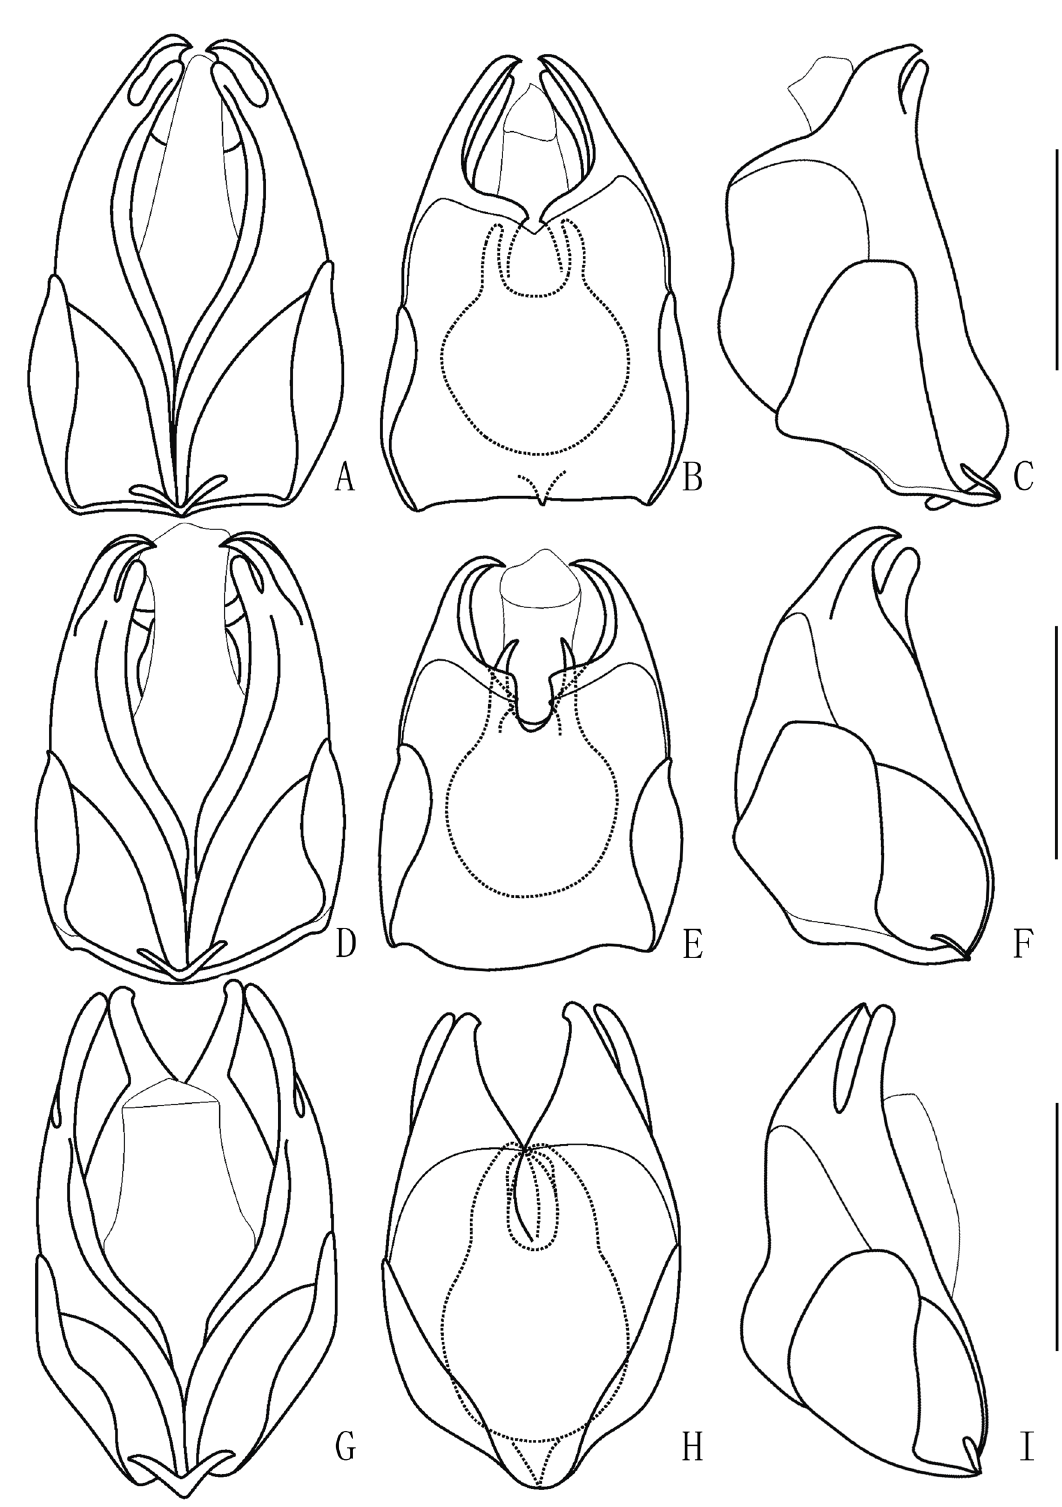
Fig. 10. Aedeagus (A, D, G = ventral view; B, E, H = dorsal view; C, F, I = lateral view). A‒C . Stenothemus chongqingensis Y. Yang & H. Liu sp. nov., holotype (MHBU HBU(E) 410028). D‒F . S. flavicollis Y. Yang & S. Ge sp. nov., holotype (MHBU HBU(E) 410029). G‒I . S. jindraimimus Y. Yang & X. Yang sp. nov., holotype (IZAS IOZ(E) 1389239). Scale bars: 0.5